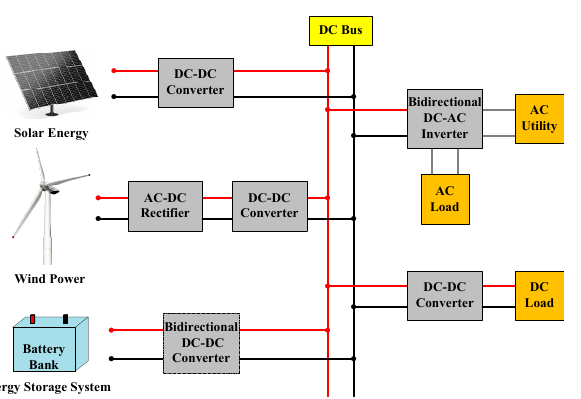
Figure 1. Configuration of a distributed generation system with an energy storage system.